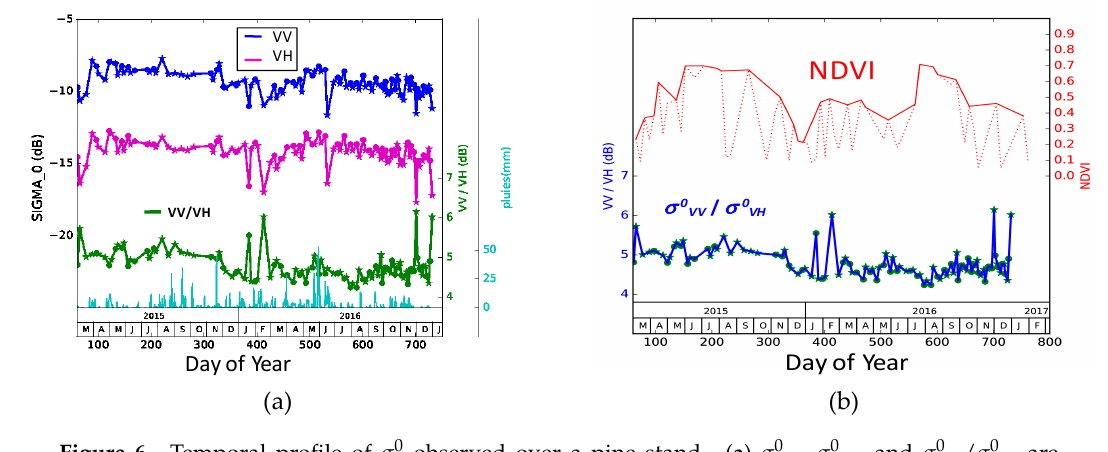
, σ 0 , and σ 0 / σ 0 are VV VH VV VH